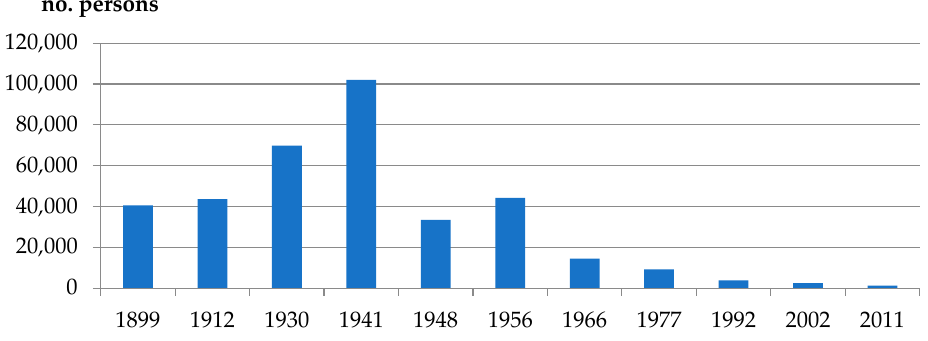
Figure 1. Delimitation of the Jewish Quarter (1939/2022) within the city of Bucharest. Source: author, 2022.